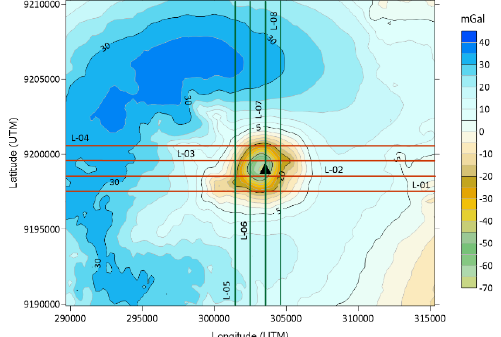
Fig. 9. The residual gravity anomaly contour map which has been cut to the modeling boundaries. This contour is equipped by track of AB and CD used as input data for invers